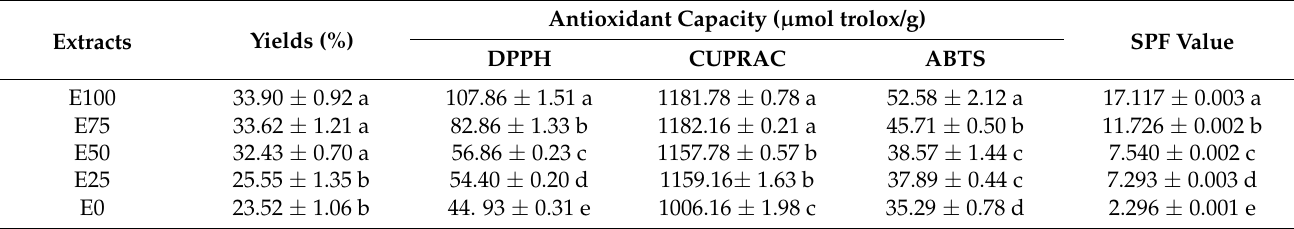
Table 1. The yield of extraction, antioxidant capacity, and SPF value of D. acehensis resin extracts.